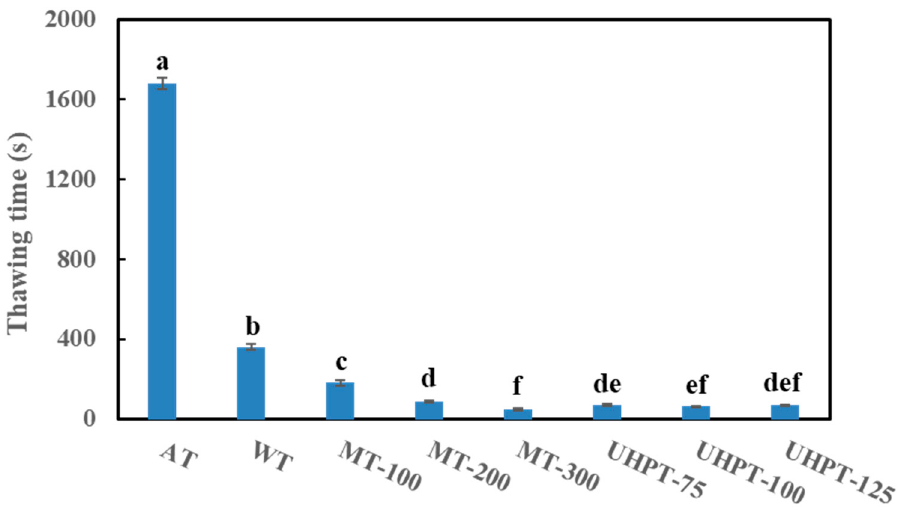
Figure 2. The thawing time of frozen mangoes that were affected by different thawing conditions. The different lowercase letters mean the significant difference among thawing conditions ( p < 0.05).